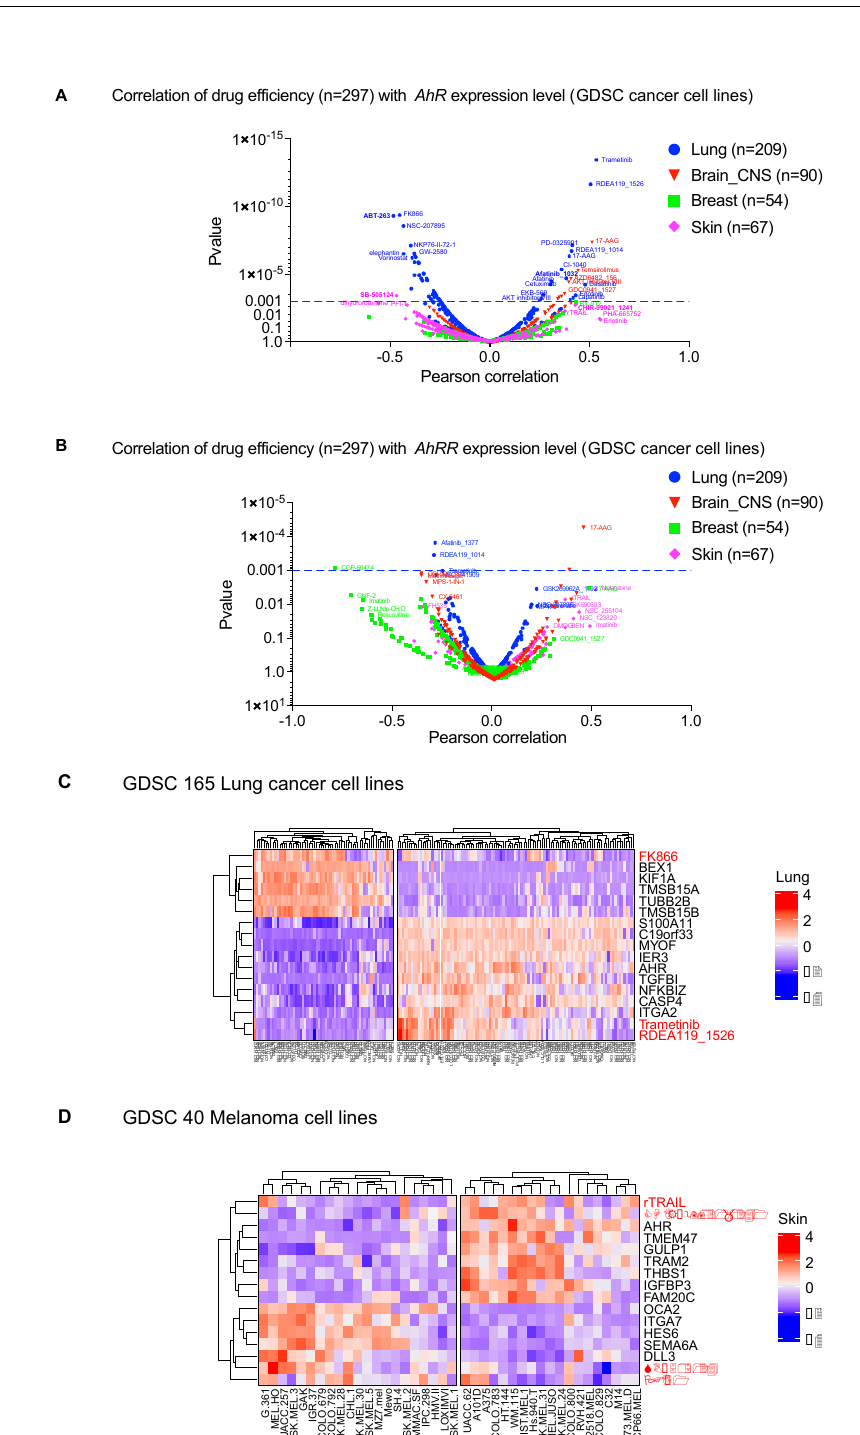
A Correlation of drug efficiency (n=297) with AhR expression level (GDSC cancer cell lines)